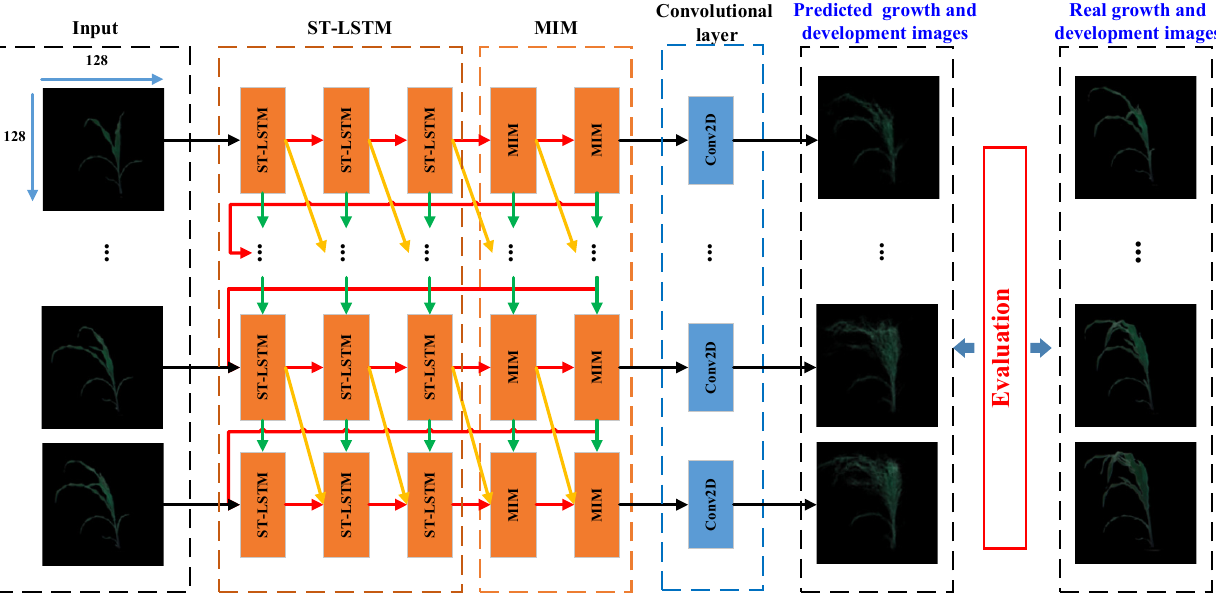
l H − − for differential modeling. Green arrows: the 1 p for differential modeling. Green arrows: the p − 1 l C , l D and S − . Red arrows: the zigzag state p p 1 p . Red arrows: the zigzag state p − 1